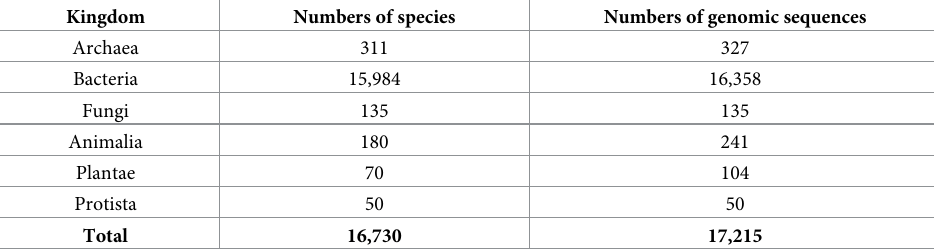
Table 1. Statistics of species and their genomic sequences in